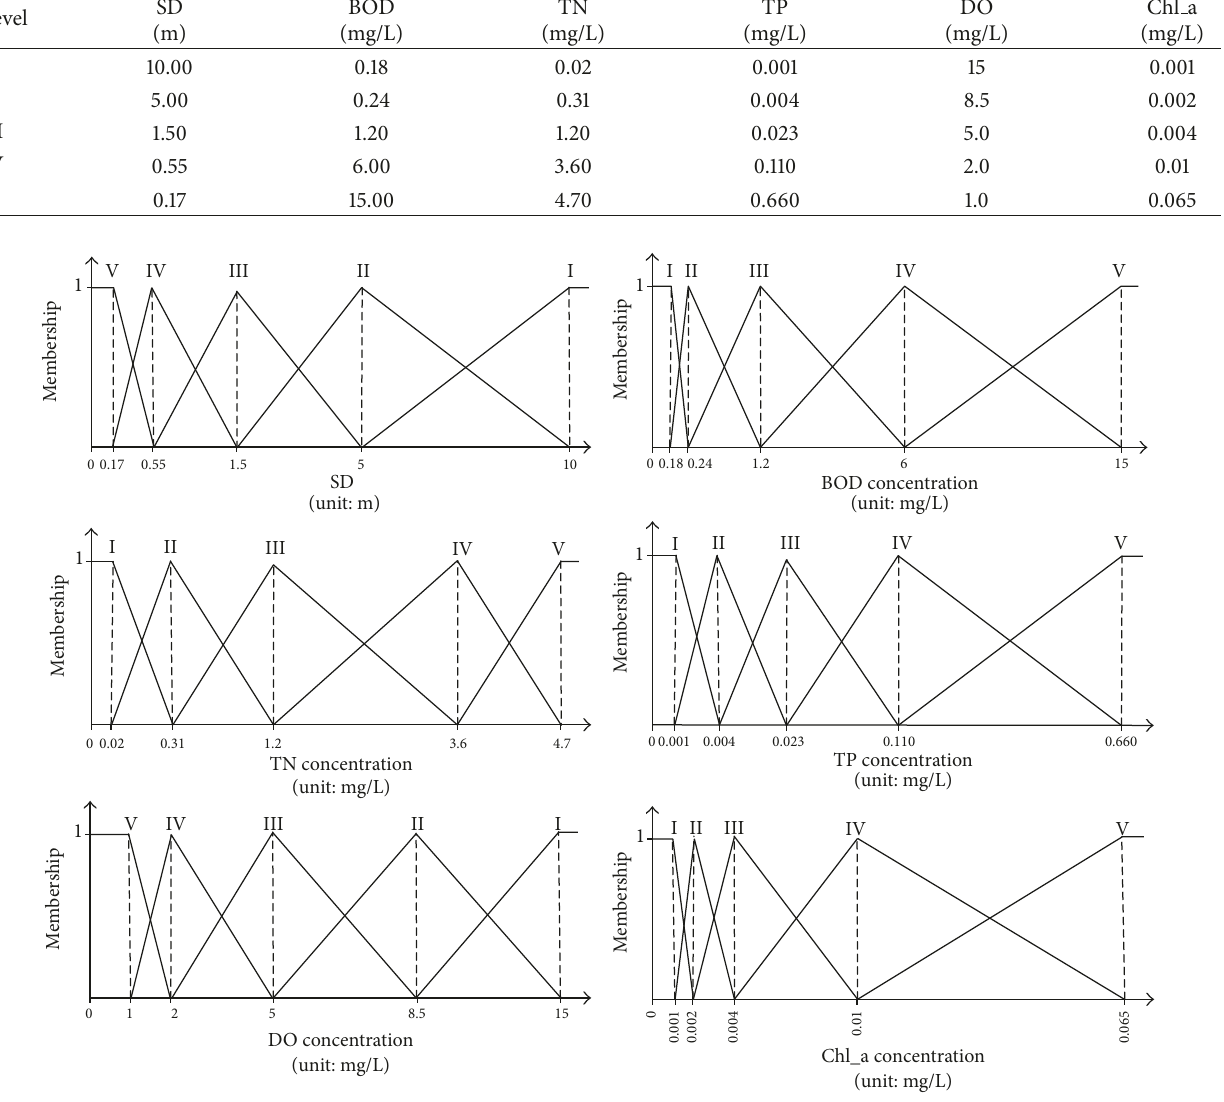
Figure 3: Triangular linear membership functions of the water quality